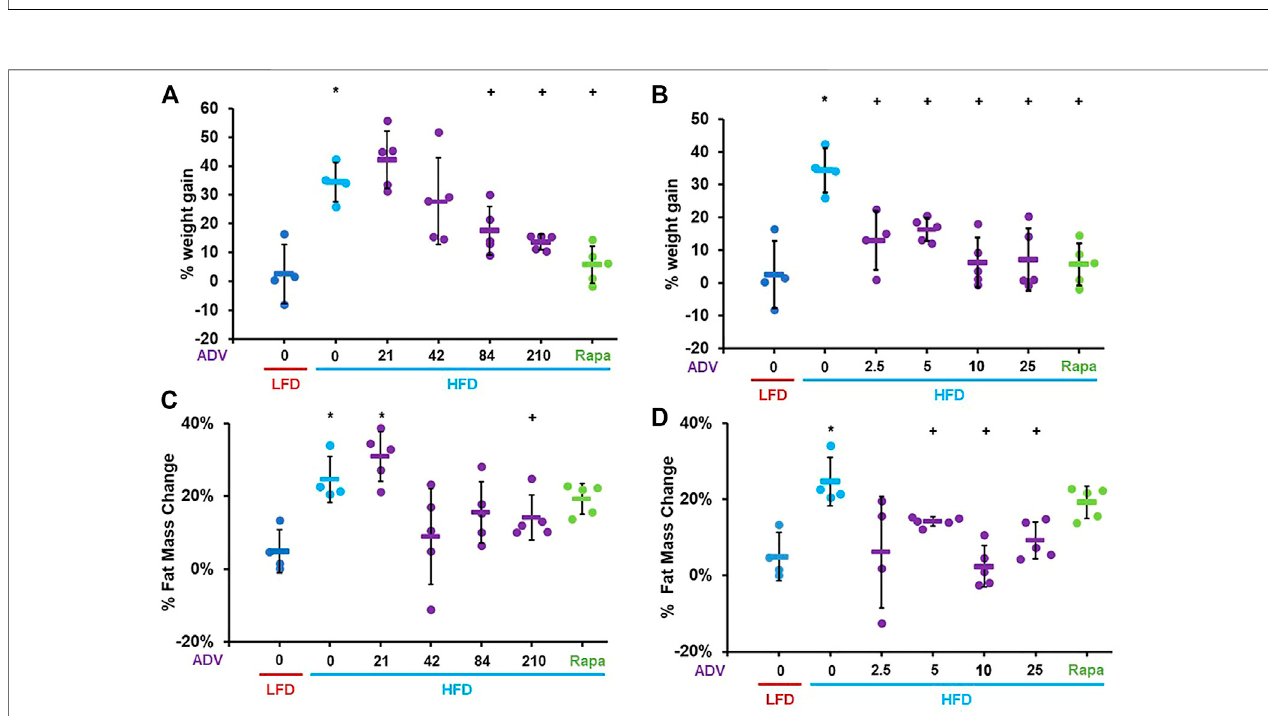
FIGURE 4 | Adefovir dipivoxil prevents diet-induced obesity in mice. Percent weight change in mice fed either LFD or HFD and treated with increasing concentrations of adefovir dipivoxil (ADV) in the chow (A) or by intraperitoneal injection (B) Percent fat mass change in mice fed either LFD or HFD and treated with increasing concentrations of adefovir dipivoxil (ADV) in the chow (C) or by intraperitoneal injection (D) Circles: individual animals, bars: average + - standard deviation. *: p < 0.05 vs LFD control, **: p < 0.01 vs LFD control, +: p < 0.05 vs HFD control, ++: p < 0.01 vs HFD control.